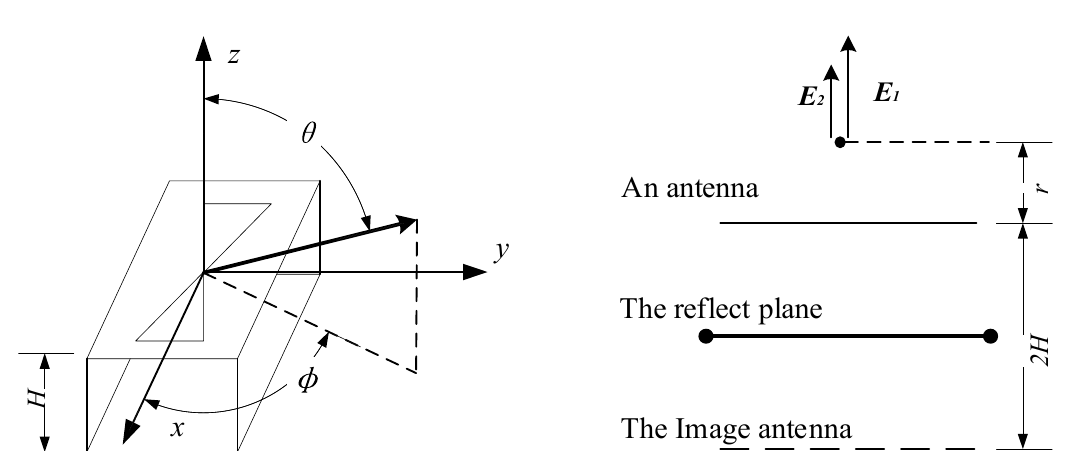
Figure 6. These two pictures show the principle of cavity. ( a ) A piece of Bow-tie copper sheet mounted on an infinite reflect plane is displayed; ( b ) The structure of reflect plane produces an image antenna to improve the directivity of antenna.